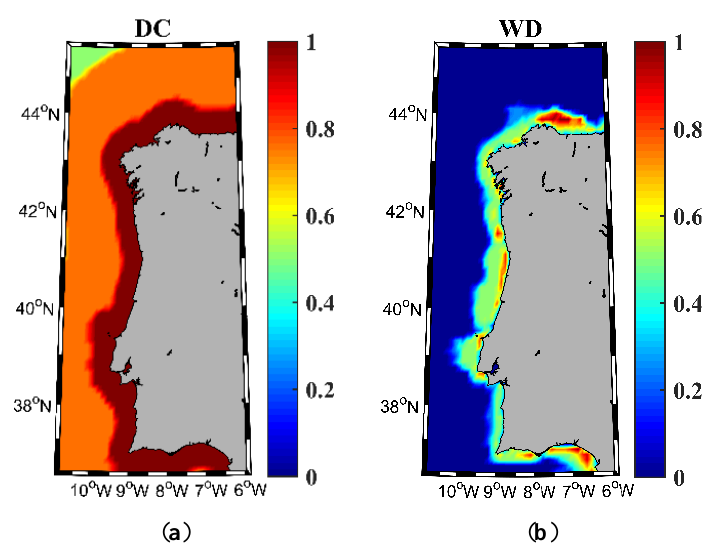
Figure 7. Cost indices: ( a ) distance to coast (DC), and ( b ) water depth (WD) for wind and wave energy resources in the NW Iberian Peninsula for the near future (2026–2045).